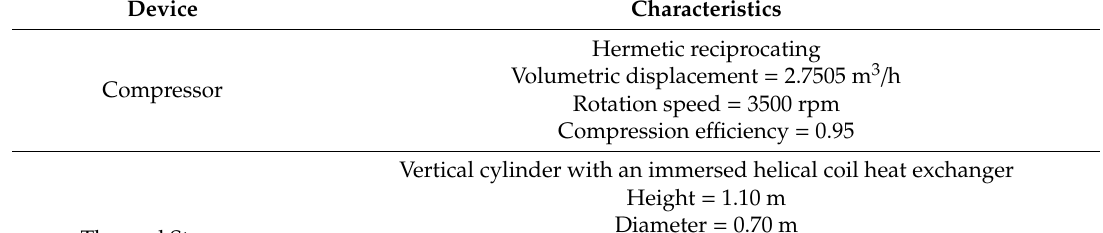
Table 1. System technical / design specifications of the DXSAHP